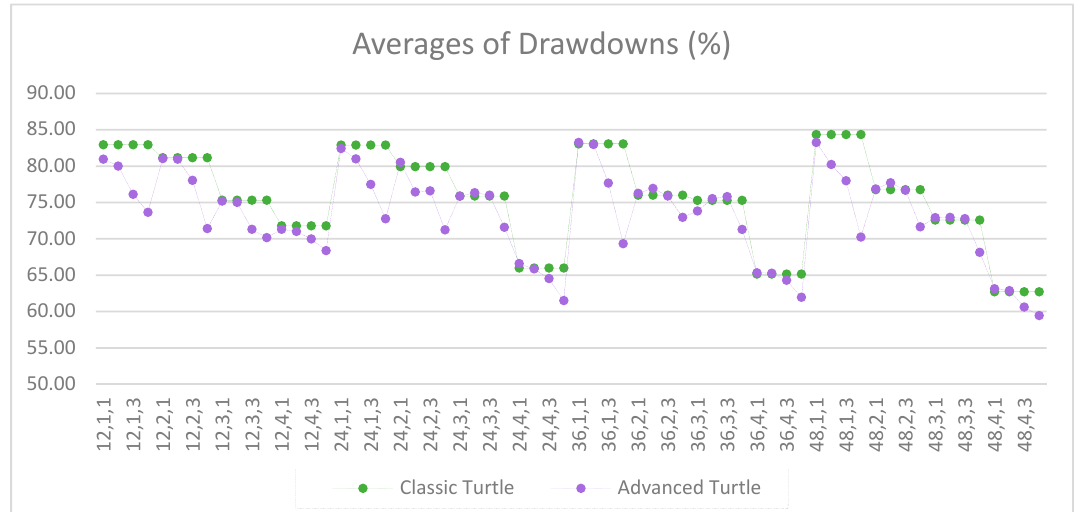
Figure 11. Averages of profits between the classic and the advanced Turtle systems for every combination of N, X, Y for the medium parameters (40, 80).